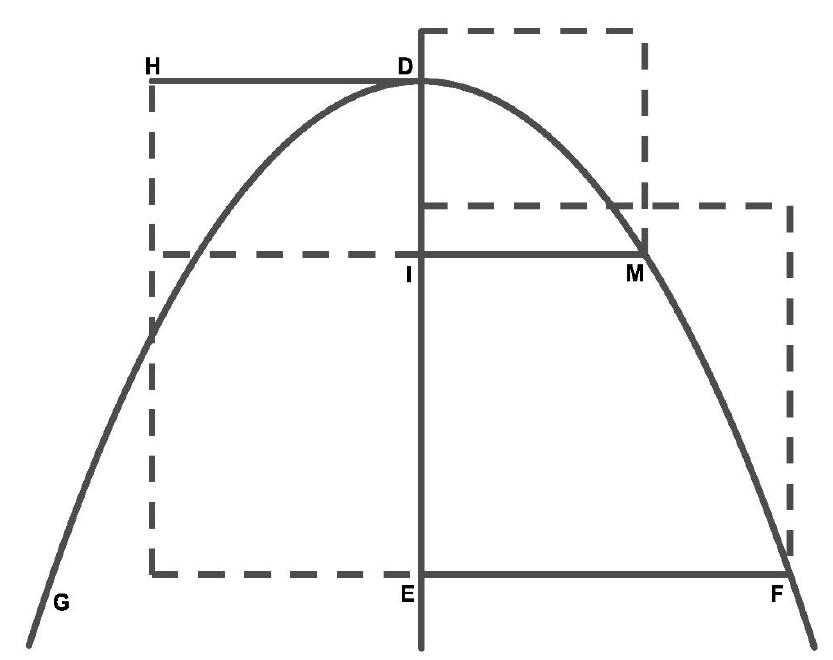
Figure 3. Parabola of vertex 𝐷 and diameter 𝐷𝐸 , as defined in prop. 1.10 in the text.